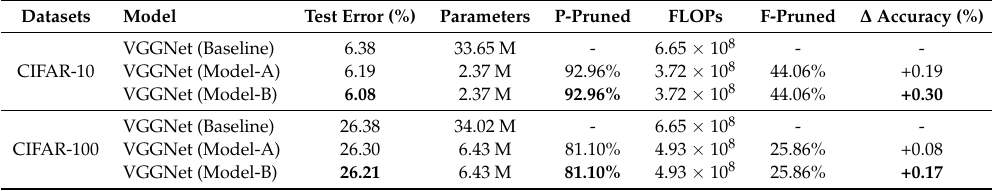
Table 4. The results obtained on the CIFAR-10 and CIFAR-100 datasets. P-Pruned refers to the pruned ratio of parameters, and F-Pruned refers to the pruned ratio of floating-point operations per second (FLOPs). The best results are highlighted with bold face.